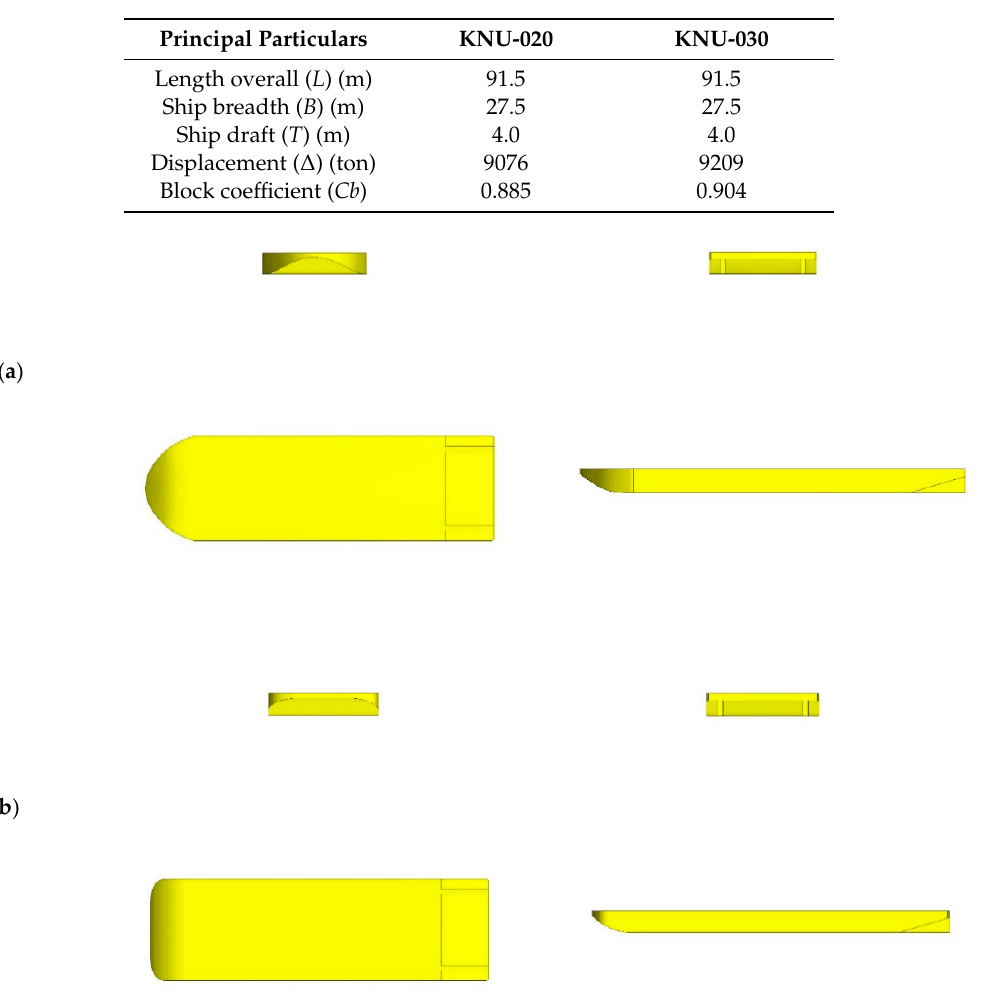
Table 1. Principal particulars of the barge.